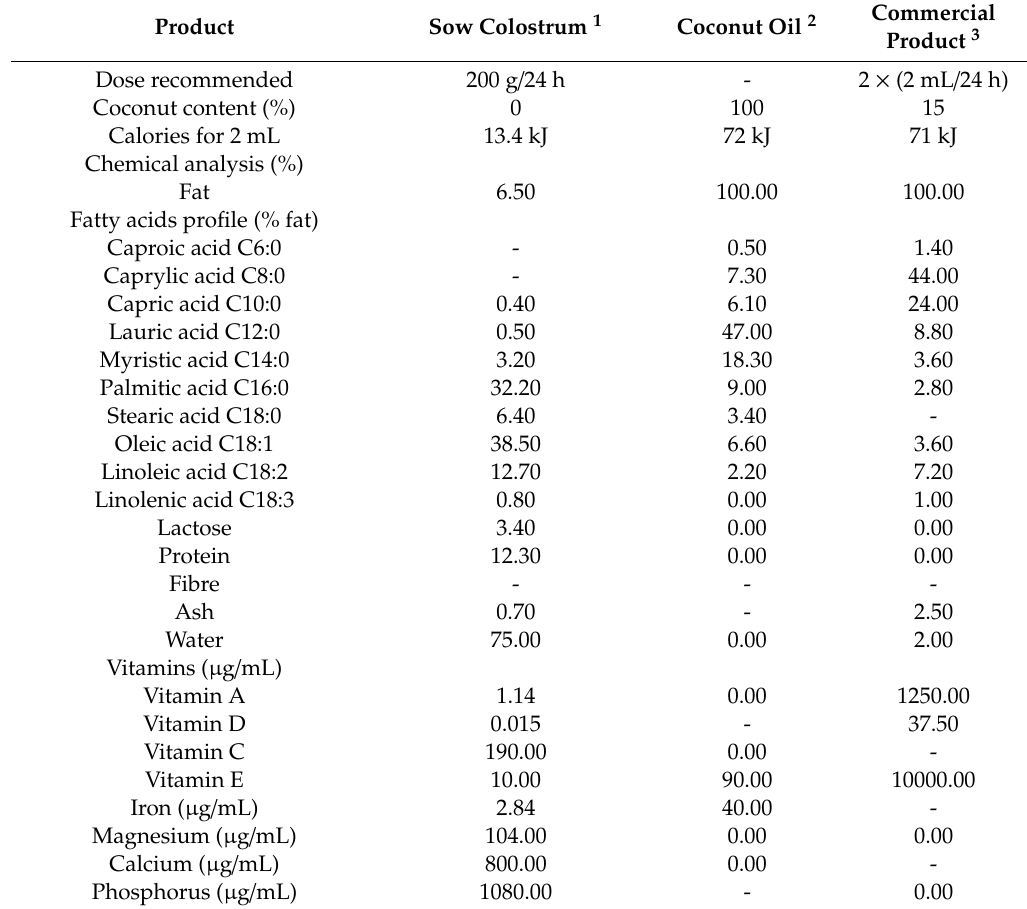
Table 2. Details of the composition of the two energy supplements (coconut oil and commercial product) used in the study and of sow colostrum [18] for comparison. Unless stated otherwise values are in percentage of total composition. Commercial Product Sow Colostrum 1 Coconut Oil 2 Product 3 200 g / 24 h 2 × (2 mL / 24 h) 0 100 15 13.4